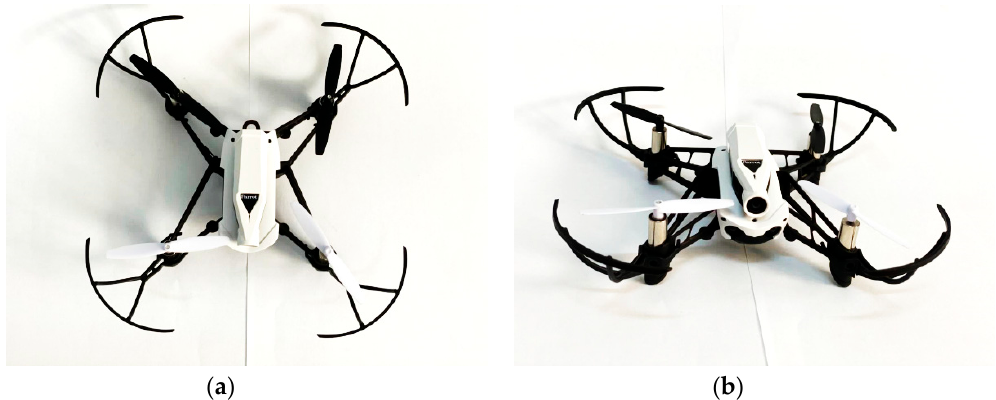
Figure 5. ( a ) The Parrot Mambo FPV drone-top view, ( b ) the Parrot Mambo FPV drone-frontal